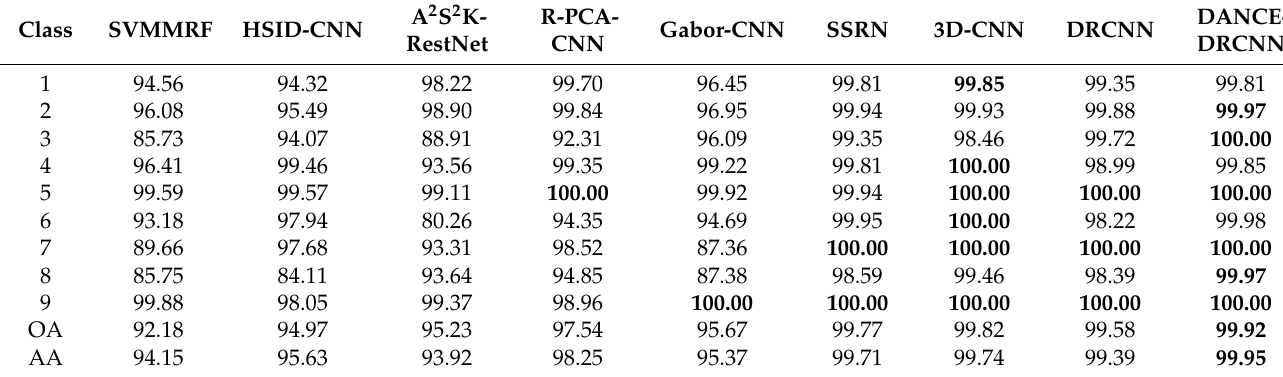
Table 7. Comparison of the classification accuracy (%) among the proposed method, DRCNN, and the baselines on the Pavia University